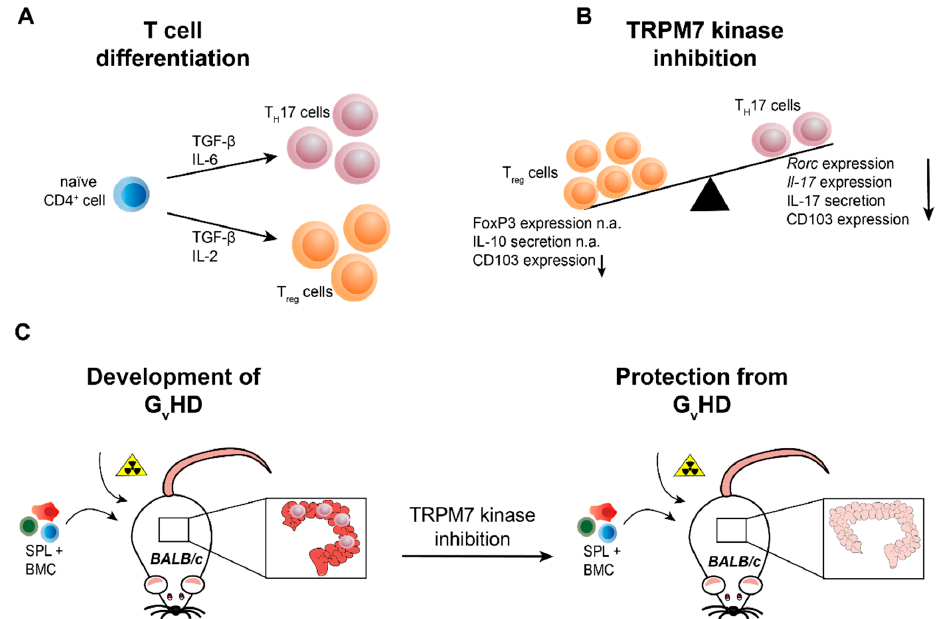
Figure 4. TRPM7 kinase is essential for T cell differentiation into the pro-inflammatory T H 17 cell type and the development of graft versus host disease. ( A ) Naïve CD4 + T cells differentiate into pro-inflammatory T H 17 cells in the presence of TGF- β and IL-6. For the differentiation into anti-inflammatory regulatory T cells (T regs ), the cytokines TGF- β and IL-2 are required. ( B ) Genetic inactivation of TRPM7 kinase activity ( Trpm7 R/R ) results in reduced T H 17 cell differentiation, indicated via diminished Rorc and Il-17 mRNA expression as well as IL-17 serum levels, while T reg cell differentiation, evident via FoxP3 expression and IL-10 serum levels, is unaltered. In addition, integrin α E (CD103) expression is reduced in TRPM7 kinase deficient T cells. ( C ) Transplantation of bone marrow cells (BMC, C57BL/6) in conjunction with splenocytes (SPL, C57BL/6) triggers the development of graft versus host disease (G V HD) in lethally irradiated mice with different genetic background (BALB/c), manifesting in massive tissue destruction of the intestine but also lung and skin tissues. TRPM7 kinase deficient BMC and SPL transplantation does not induce inflammation in the intestine and ameliorates or even prevents disease progression, suggesting TRPM7 kinase inhibition as valid tool for the treatment of G V HD. n.a. (not altered).